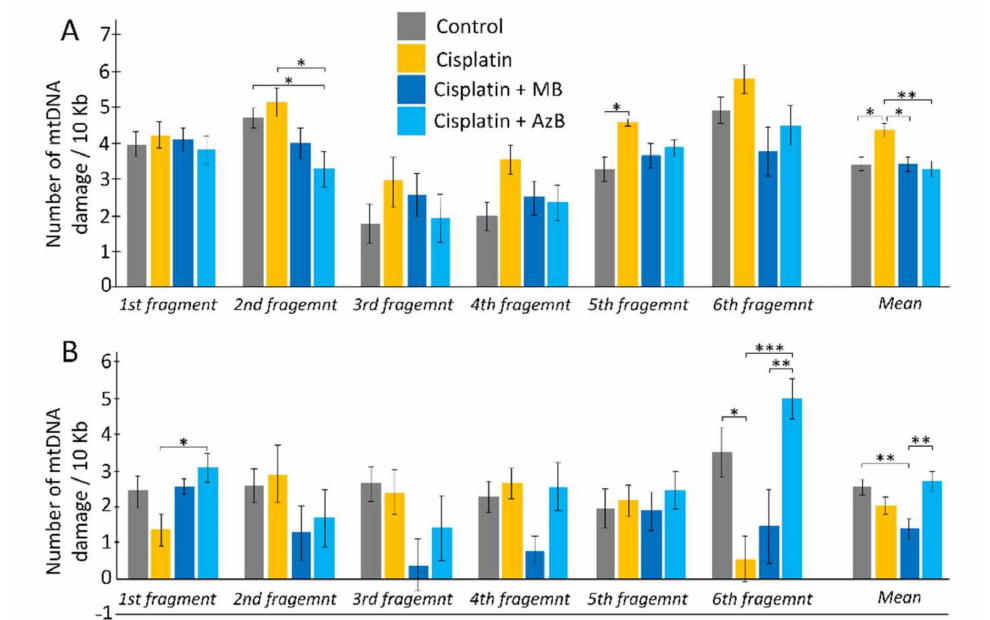
Figure 6. Copy number of mtDNA in the ( A ) cortex, ( B ) hippocampus. The results expressed as means ± SEM. Control n = 11, Cisplatin = 6, Cisplatin + MB = 8, Cisplatin + AzB = 8. * p < 0.05, ** p < 0.01, *** p < 0.001 comparison of the control group and treated groups using Tukey’s post-hoc